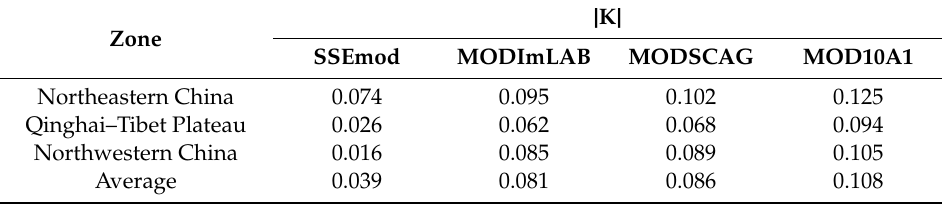
Table 3. The average of the absolute value of K in di ff erent snow cover regions.